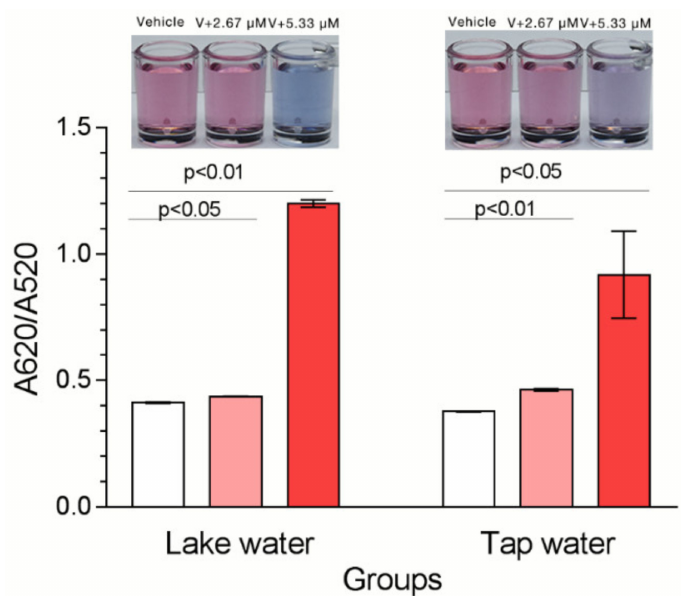
Figure 7. Gold Nanoparticles (AuNPs) assay in water samples. Signal changing of DDT_13 responses in water samples. Insert images: the color changing induced by the